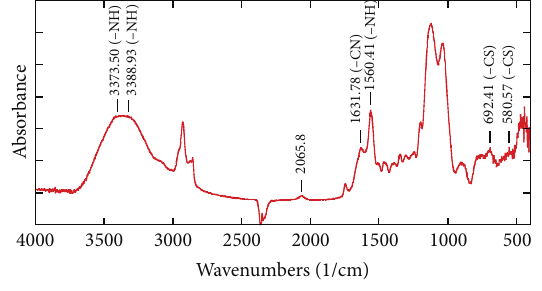
Figure 2: FT-IR spectra of PSTM-3T polymer.